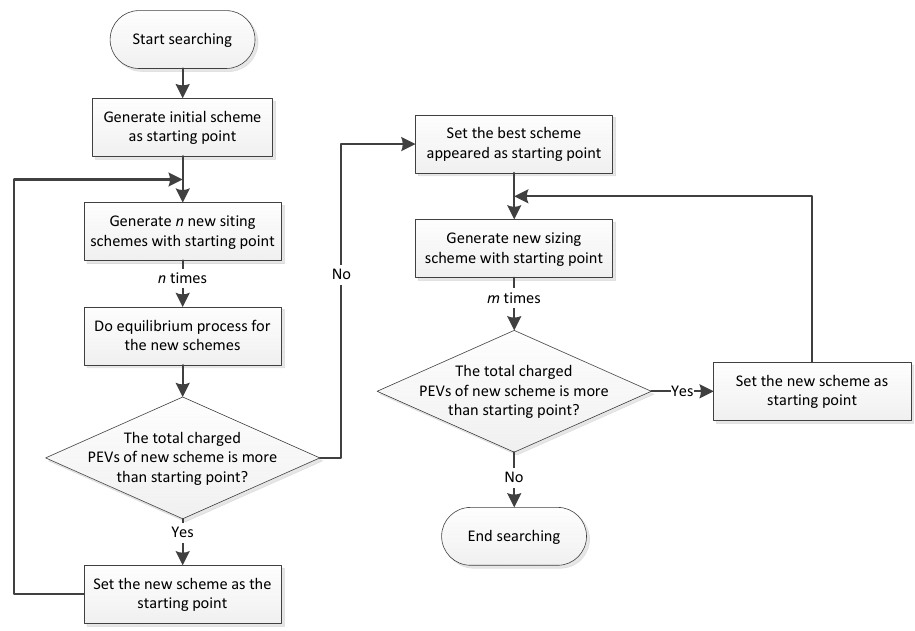
Figure 3. The flow chart of the local search algorithm.